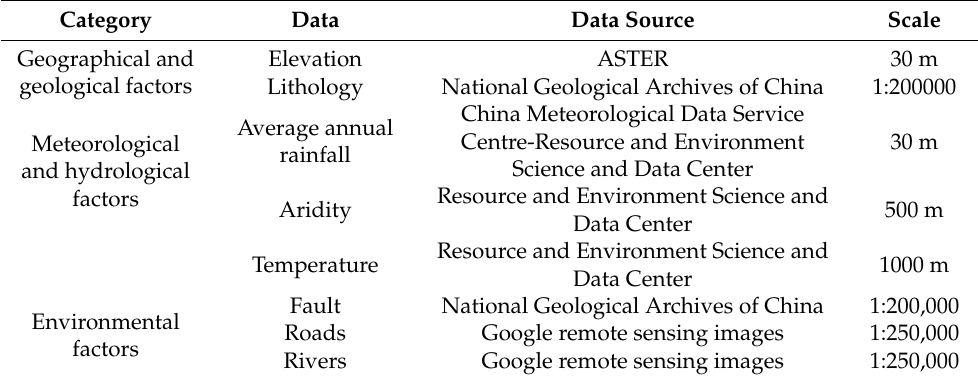
Table 2. Statistics of data